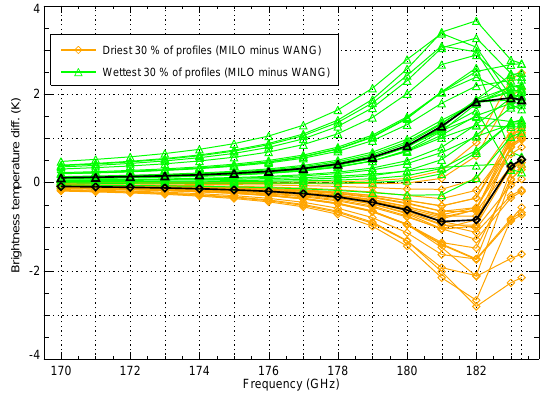
Figure 5. Downwelling brightness temperature differences between MonoRTM calculations using the WANG- and MILO-corrected RH profile as input. Data are sorted by the moistest 30% and driest 30% of all profiles in the CJC data set (green and orange, respectively). The thick black lines are the mean spectral residual for the two sub- sets of data.